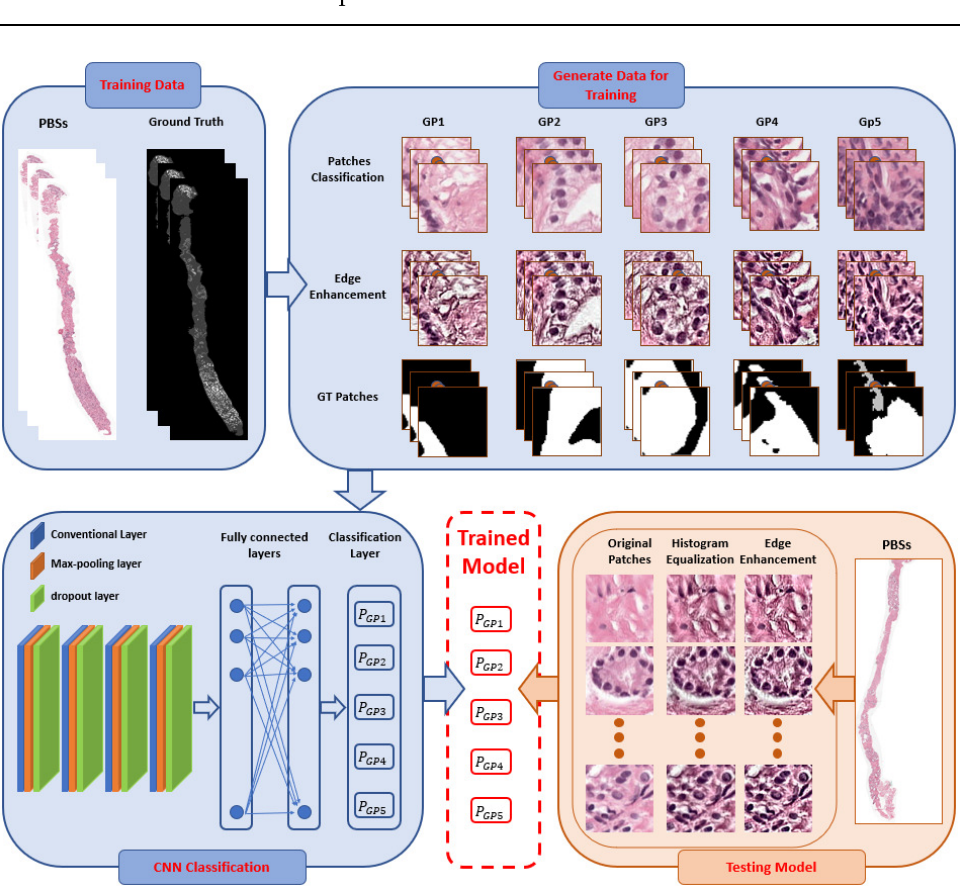
Figure 3. Proposed pipeline for patch-wise classification, while PBSs is prostate biopsy specimens and Gleason pattern labels